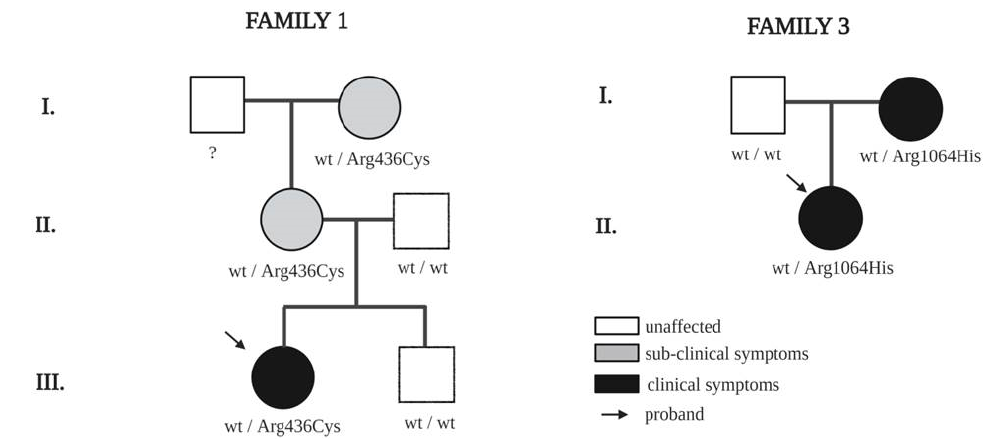
Figure 1. Pedigrees of families with TIE1 variants through three familial generations (I, II and III) in family one and through two familial generations (I and II).